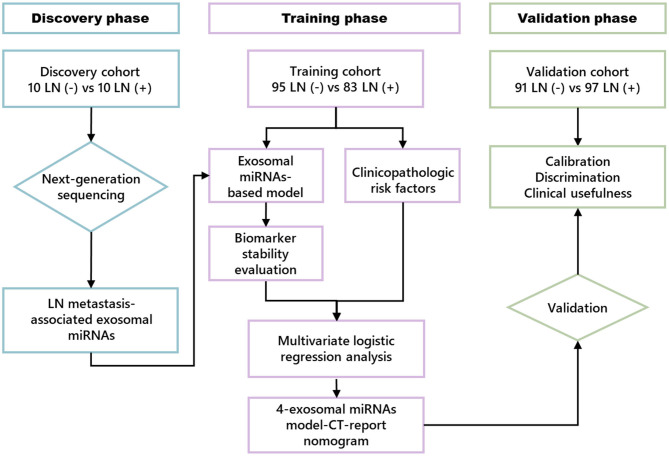
Study flowchart.